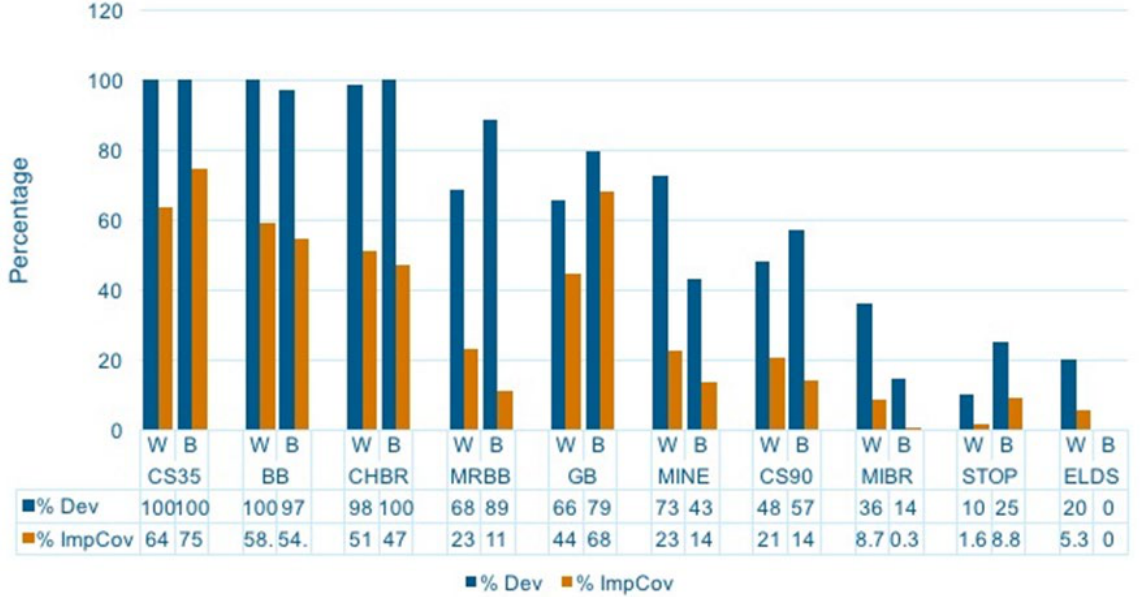
Figure 3. Percentage developed and percentage impervious cover at both sub-watershed and 100-meter buffer scales for sampling stations listed in Table 1.